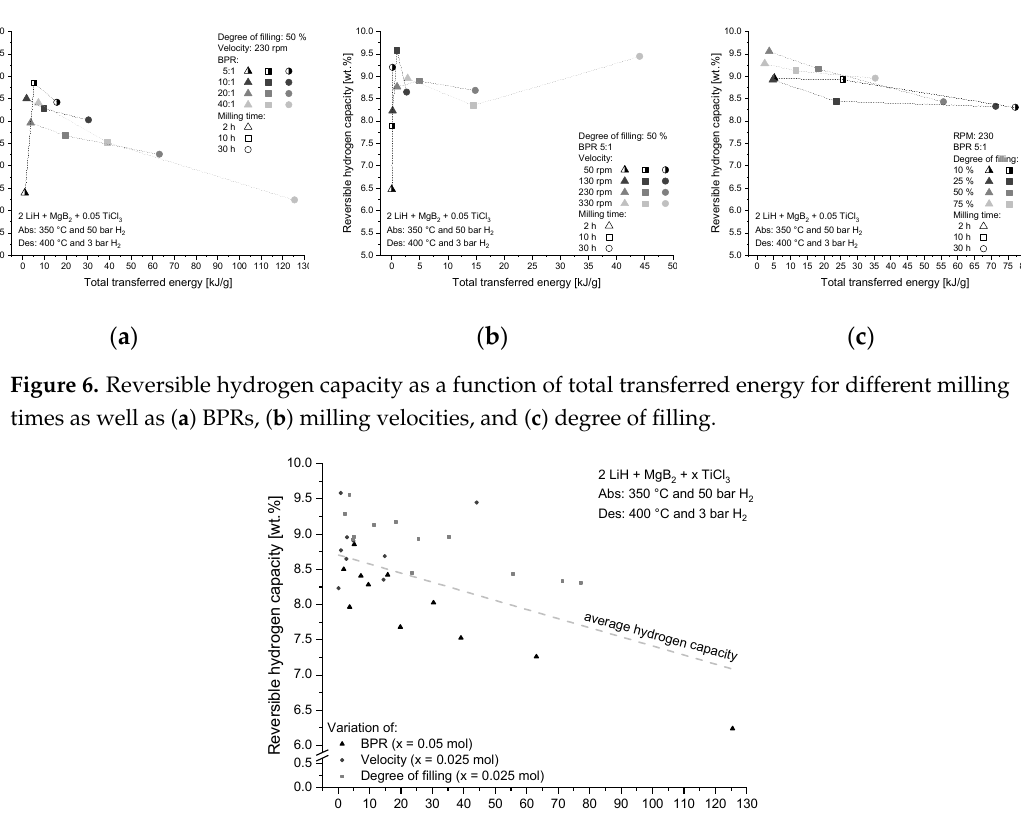
Figure 7. Hydrogen capacity (reversible) as a function of energy transfer, considering all the different milling parameters.